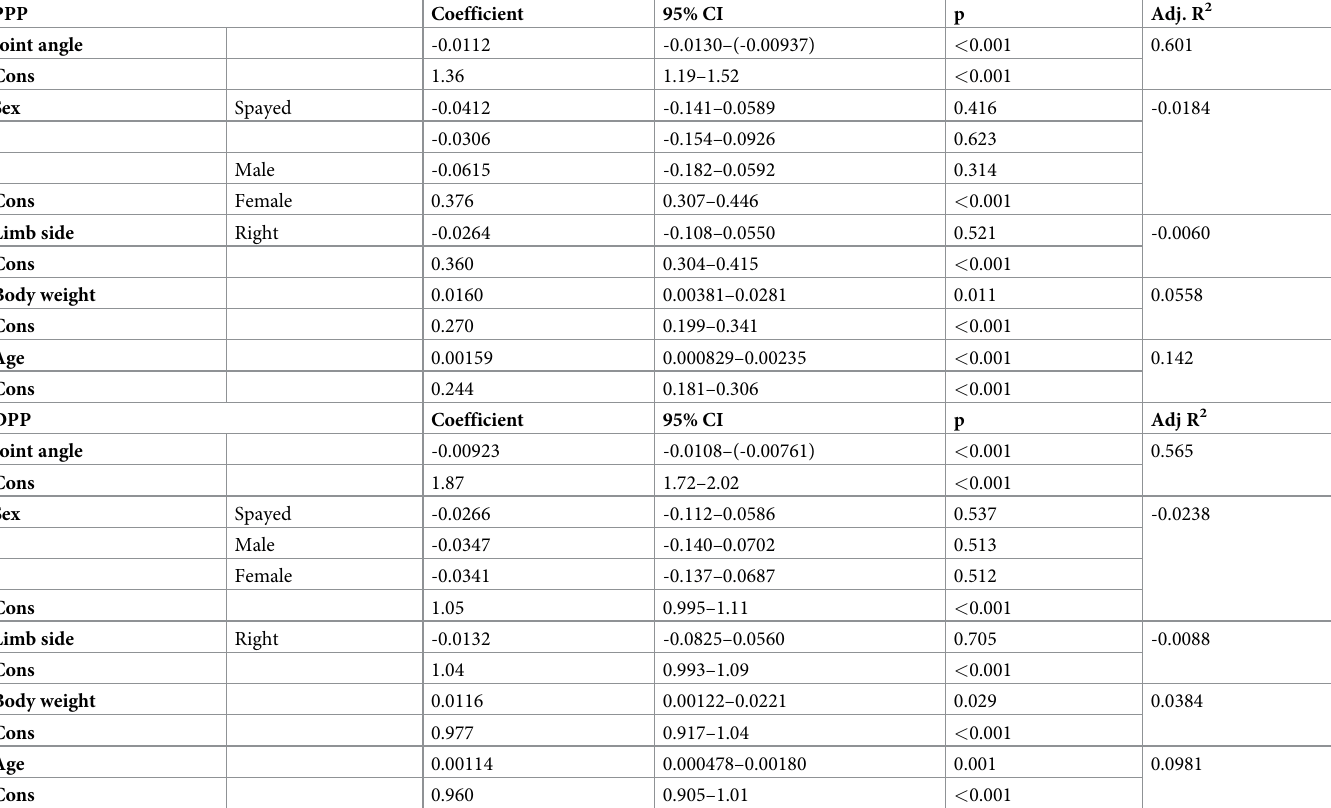
Table 3. Results of simple linear regression analyses for PPP or DPP and stifle joint angle, sex, age, body weight, or limb side.